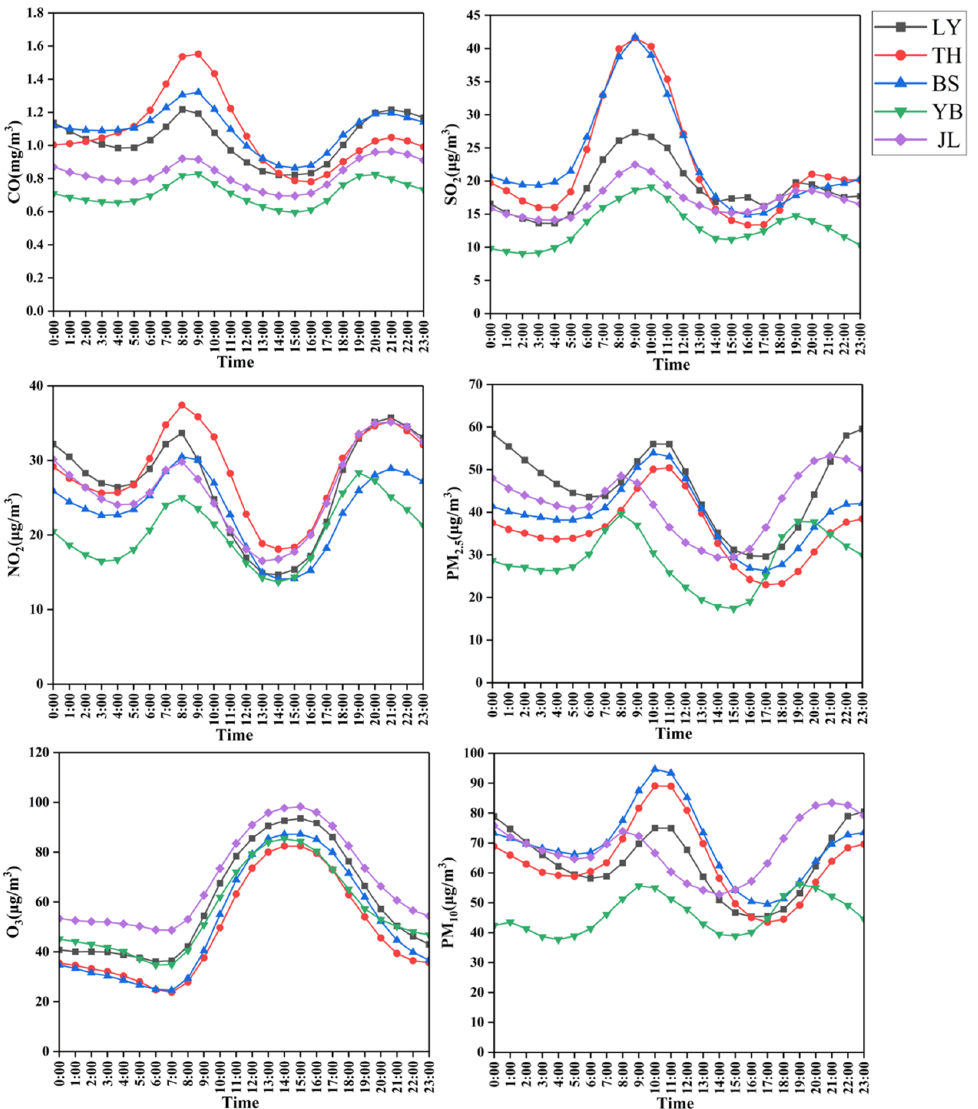
Figure 7. Hourly variation of six pollutant concentrations in different